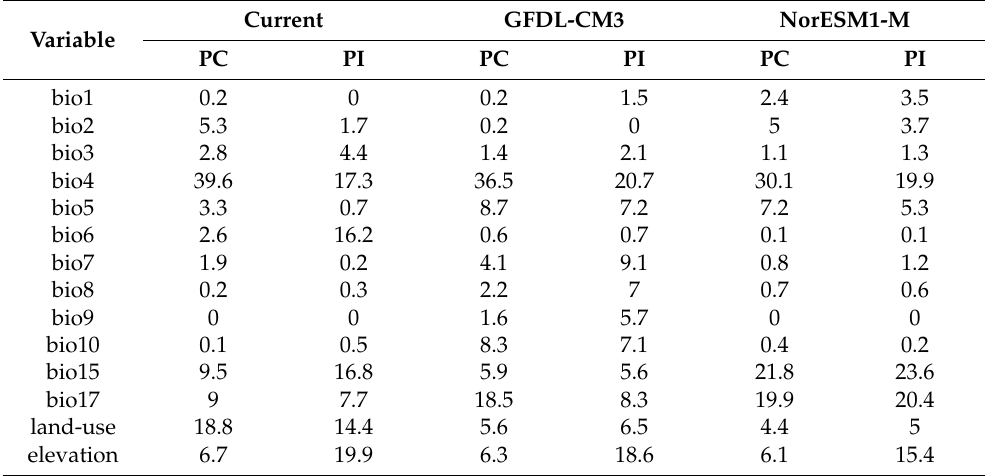
Table 2. Estimates of percent contribution (PC) and permutation importance (PI) of bioclimatic and environmental predictor variables of the MaxEnt habitat suitability modeling for the current and future (2050) distribution based on GFDL-CM3 and NorESM1-M of Kerivoula picta in Sri